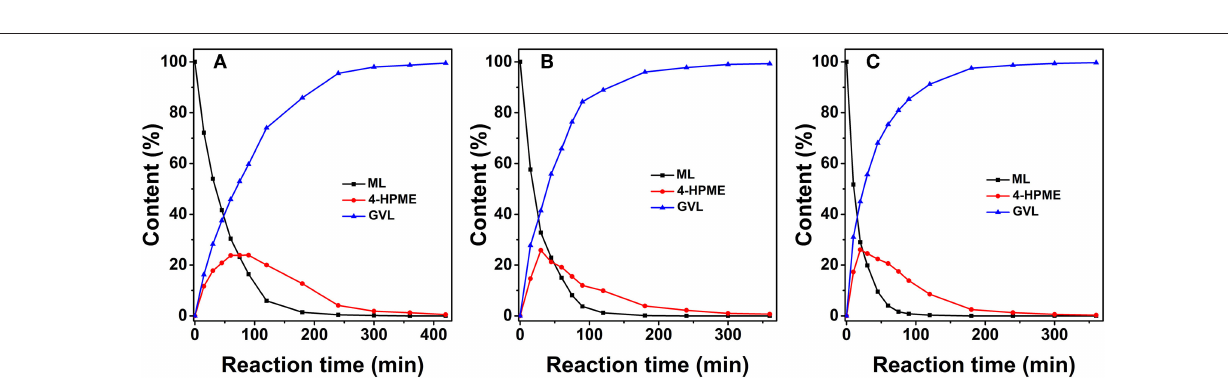
FIGURE 7 | Concentration evolution profiles of ML, MHV, and GVL vs. time over 2.0% Ru/11.7% SiW@UiO − 66 at a H 2 pressure of 0.5 MPa (A) , 1.0 MPa (B) , and 1.5 MPa (C) . Reaction conditions: 0.257g of ML, 50mg of catalyst, 15mL of H 2 O, and a temperature of 80 ◦ C.